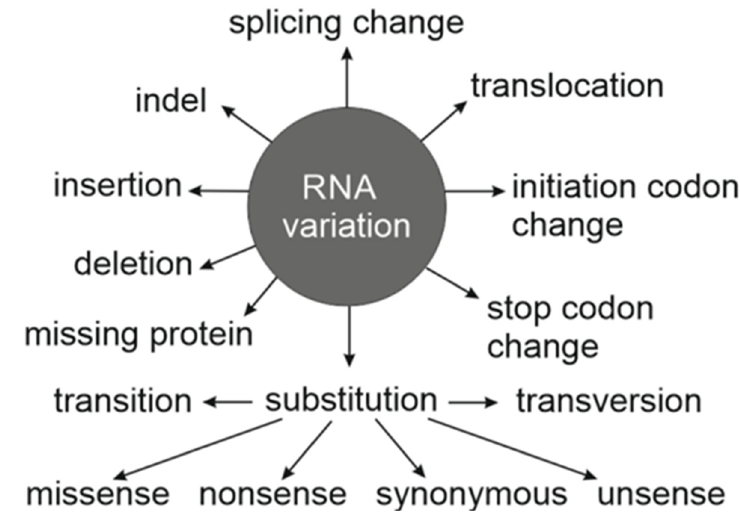
Figure 1. Types of RNA variations as described in VariO. Substitutions are divided into six categories. Transitions and transversions describe the chemical change of the base group in a nucleotide. Missense, nonsense, synonymous and the new term unsense describe the outcomes of the alterations in relation to translation, splicing, regulation and function.